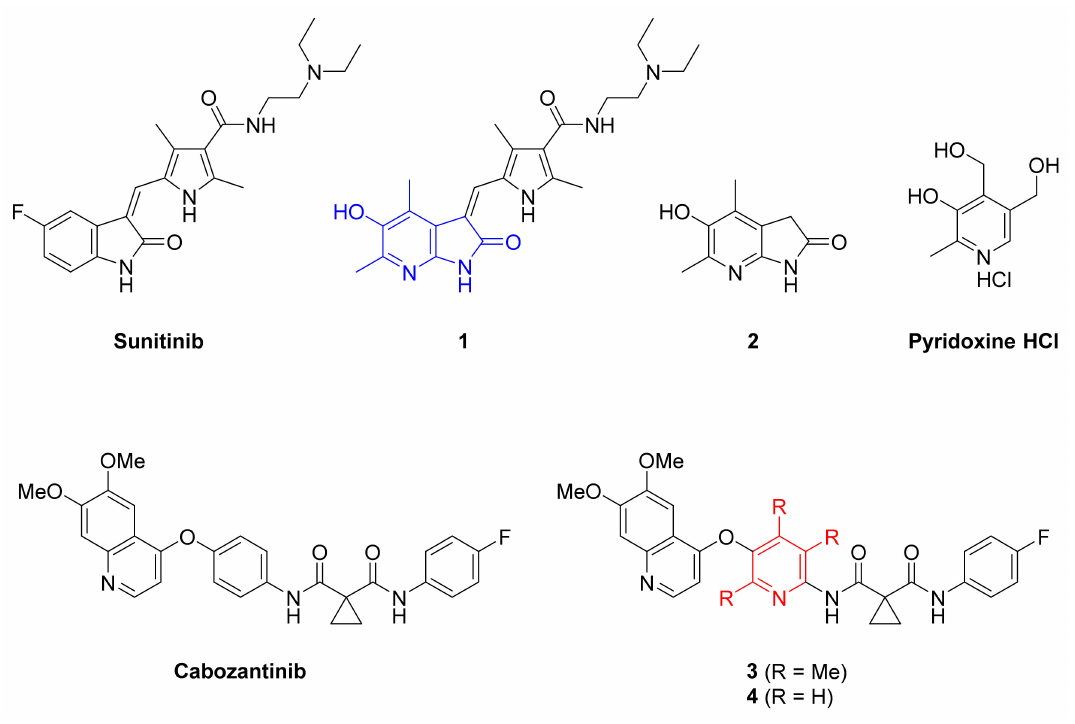
Figure 1. Bioisosteres of sunitinib and